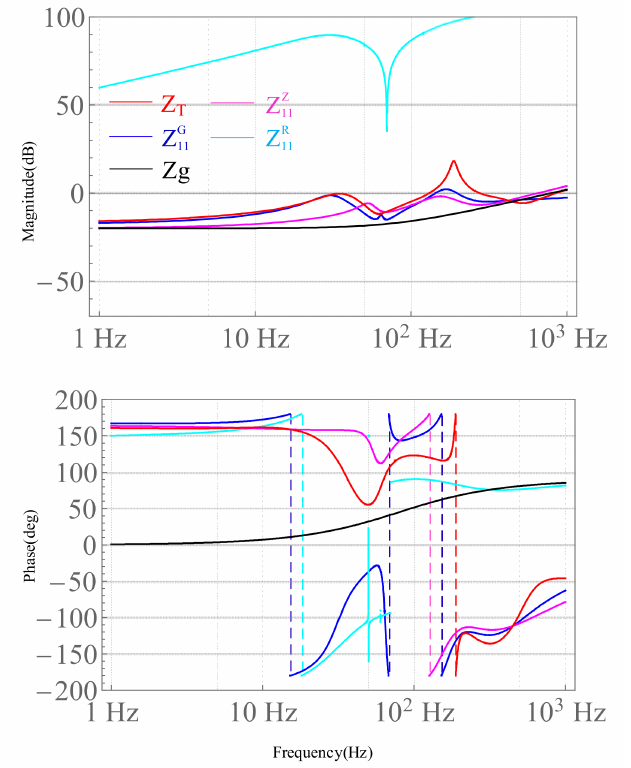
Figure 9. Entire impedance with/without the frequency coupling under L g = 0.28 mH (SCR = 4) ( Z Z 11 is the entire impedance of positive sequence without coupling. Z G is the GSC output impedance of 11 positive sequence without coupling. Z R is the GSC output impedance of positive sequence. Z g is the 11 grid impedance. Z T is the entire impedance of DFIG-based system considering coupling